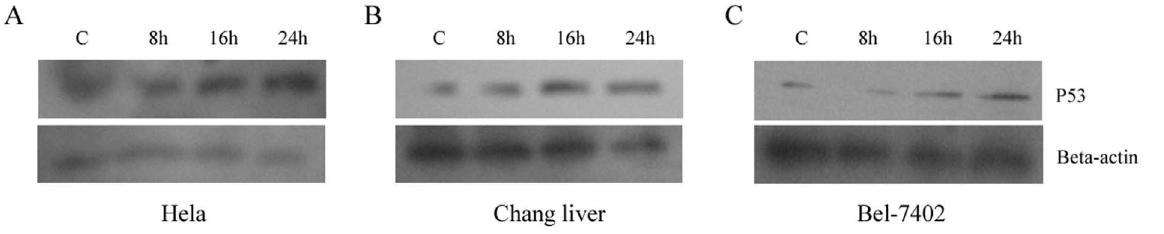
Figure 6. Levels of p53 under T-2 toxin stress. A . Levels of p53 in Hela cells when treated with T-2 at the concentration of LC50 for 8, 16, and 24 h respectively. B . Levels of p53 in Changliver cells. C . Bel-7402 cells were treated with T-2 Toxin.